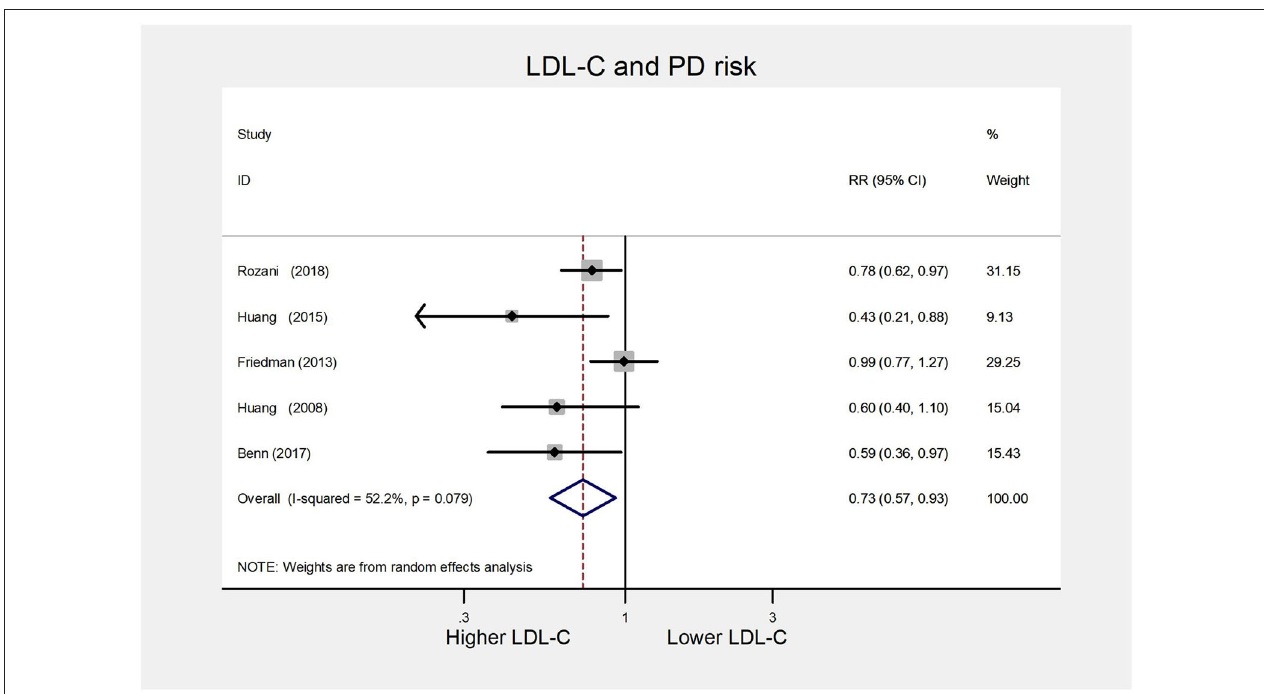
FIGURE 5 | Forest plot presenting the pooled estimate effects(RR) on the relationship between serum LDL-C levels and risk of PD. RR, relative risk; CI, confidence interval; LDL-C, low-density lipoprotein cholesterol; PD, Parkinson’s disease.